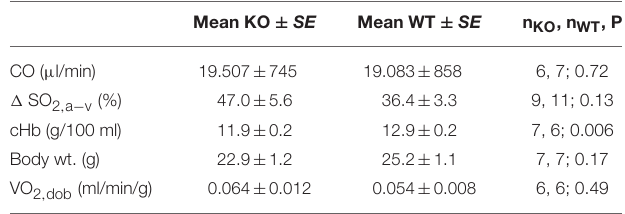
TABLE 2 | Blood gases of AQP1-deficient mice, under 40 ng/g/min dobutamine.